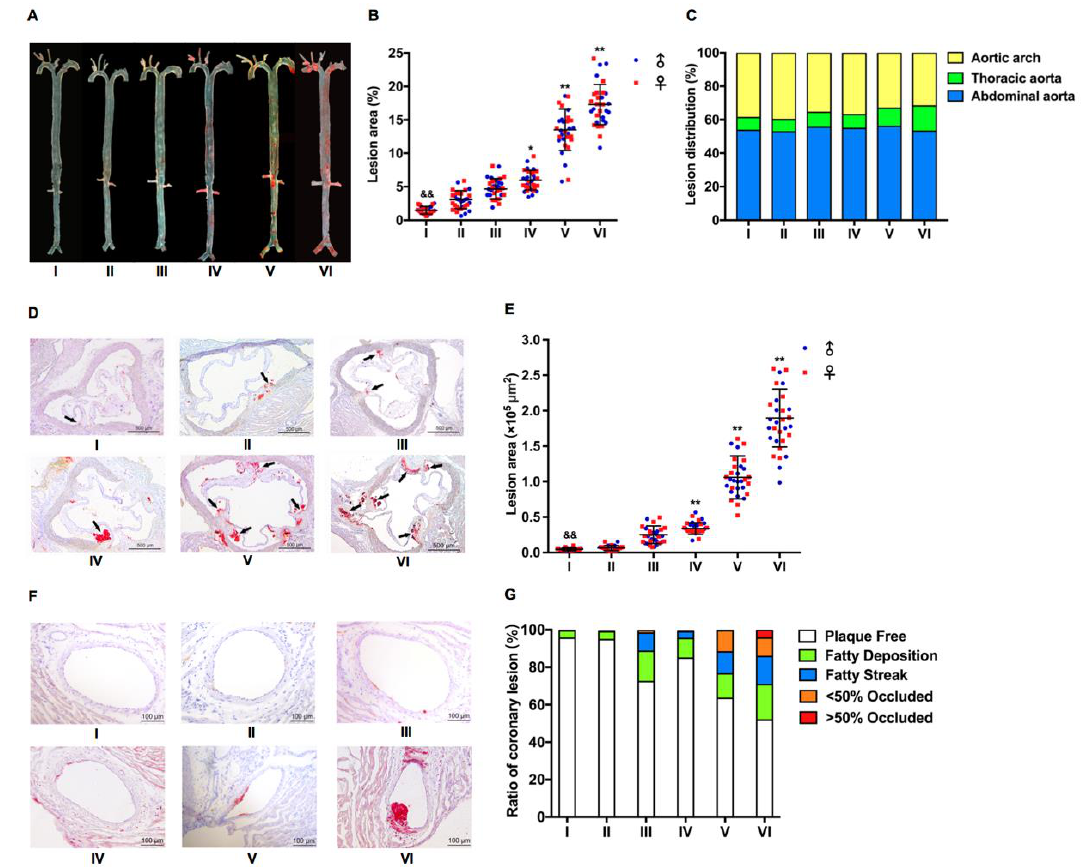
Figure 2. Characteristics of HC or HCHF diet-induced atherosclerosis in WT and LDLR+/− hamsters. ( A ) Representative en face images of Oil Red O stained whole aortas from WT and LDLR+/− hamsters on the HC or HCHF diets for 12 weeks as described above in Figure 1. ( B ) Lesion sizes in the whole aorta were quantified in the mixed-gender WT and LDLR+/− hamsters on the HC or HCHF diets for 12 weeks. n = 30/group. ( C ) Analysis of plaque distribution in WT and LDLR+/– hamsters on the HC or HCHF diets for 12 weeks. ( D ) Representative images of sectioned aortic roots with Oil Red O staining from WT and LDLR+/– hamsters on the HC or HCHF diets for 12 weeks as described above in Figure 1. Black arrows indicate Oil Red O positive staining. ( E ) Quantification of lesion areas in aortic roots. n = 30/group. ( F ) Representative images of coronary arteries stained with Oil Red O from WT and LDLR+/– hamsters on HC or HCHF diets for 12 weeks as described above in Figure 1. ( G ) Semi-quantification of atherosclerotic lesions in the coronary arteries of each group. n = 30/group. && p < 0.01 vs. group III, * p < 0.05, ** p < 0.01 vs. group IV in ( B ) and ( E ).